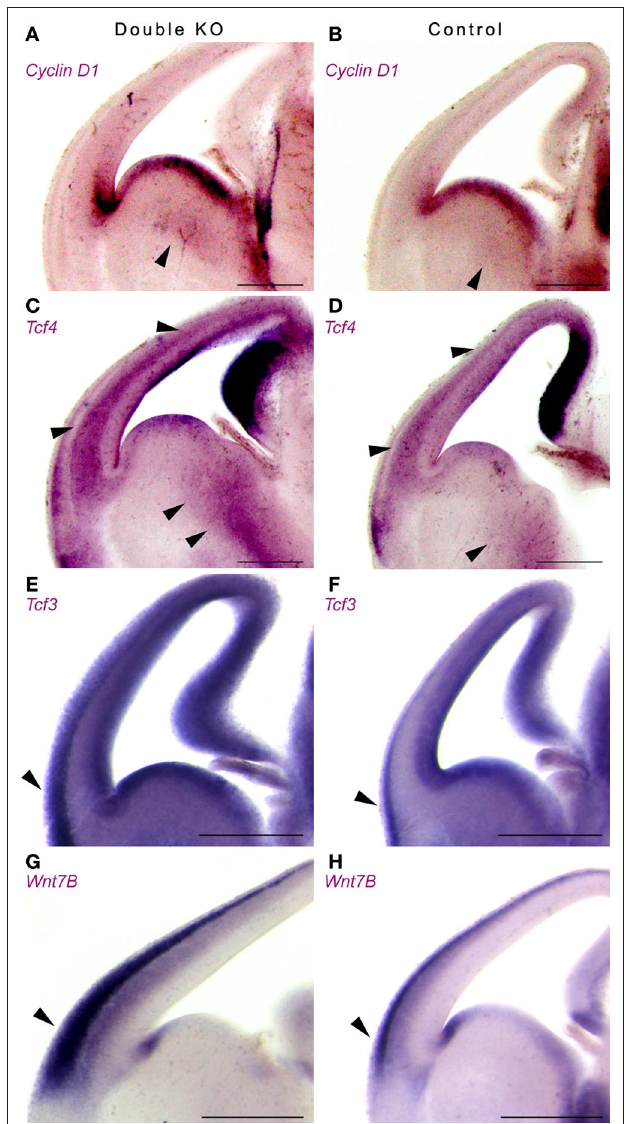
FIgure 6 | Double KO brains exhibit increased and expanded expression of downstream and upstream components of the Wnt pathway using in situ hybridization. (A,B) Expression of Cyclin D1 in double KO (A) or control (B) . Note the expansion in the area expressing Cyclin D1 in the GE. (C,D) Expression of Tcf4 in double KO (C) or control (D) . Arrowheads mark the comparable GE area, as well as cerebral cortex area (e,F) Expression of Tcf3 in double KO (e) or control (F) . Note the mutually exclusive pattern of expression between the Tcf3 and Tcf4 . (g,H) Expression of Wnt7B in double KO (g) or control (H) . The area that expressed high levels of nuclear β -catenin is marked with arrowheads. Scale bars are 0.5 mm.